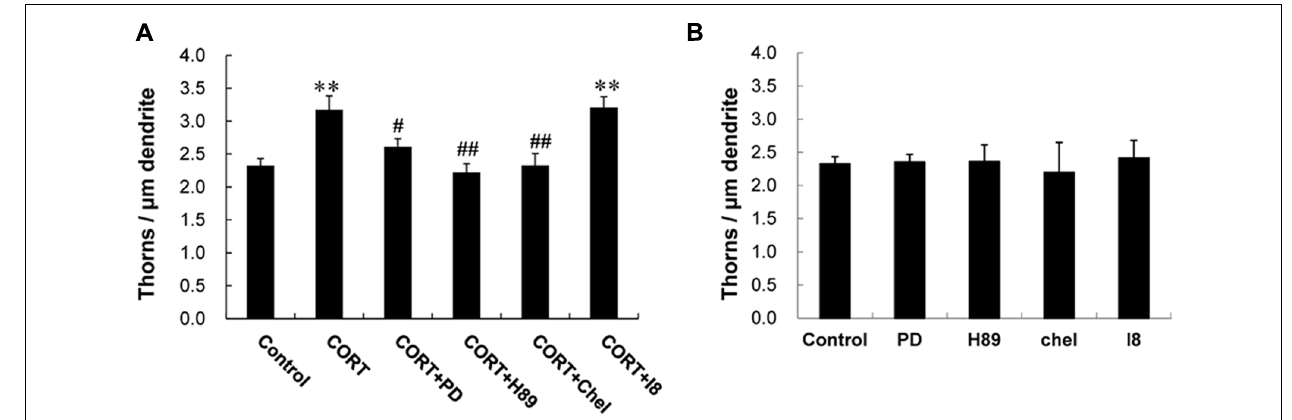
in CA3 neurons. Abbreviations are the same as (A) .Vertical axis is the average number of thorns per 1 μ m of dendrite. Results are reported as mean ± SEM.The significance of CORT or drug effect was examined using theTukey–Kramer post hoc multiple comparisons test when one way ANOVA tests yielded P < 0.05. ∗∗ P < 0.01 vs. Control. # P < 0.05, ## P < 0.01 vs. CORT. For each drug treatment, we investigated 3 rats, 6 slices, 12 neurons,